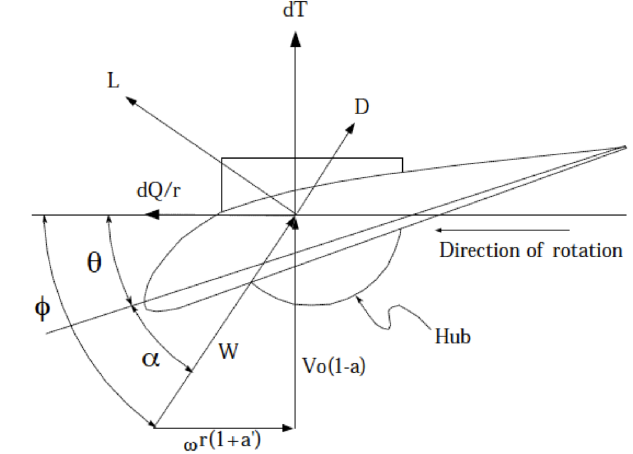
Figure 6. Blade element momentum forces and velocities.